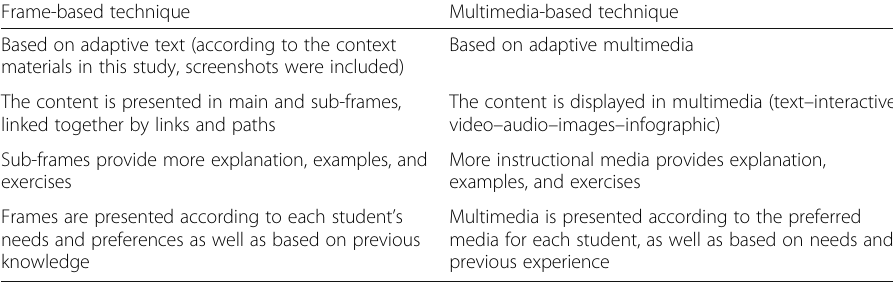
Table 1 Comparison of frame-based technique and multimedia-based technique Frame-based technique Multimedia-based